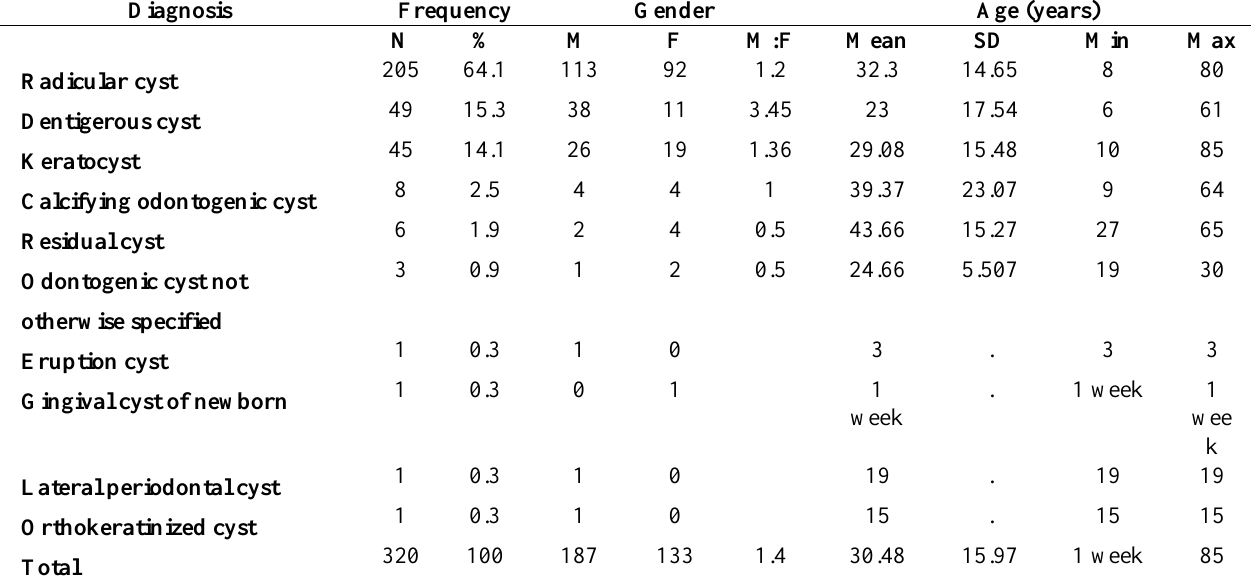
Table 1: The frequency and distribution of odontogenic cysts according to gender and